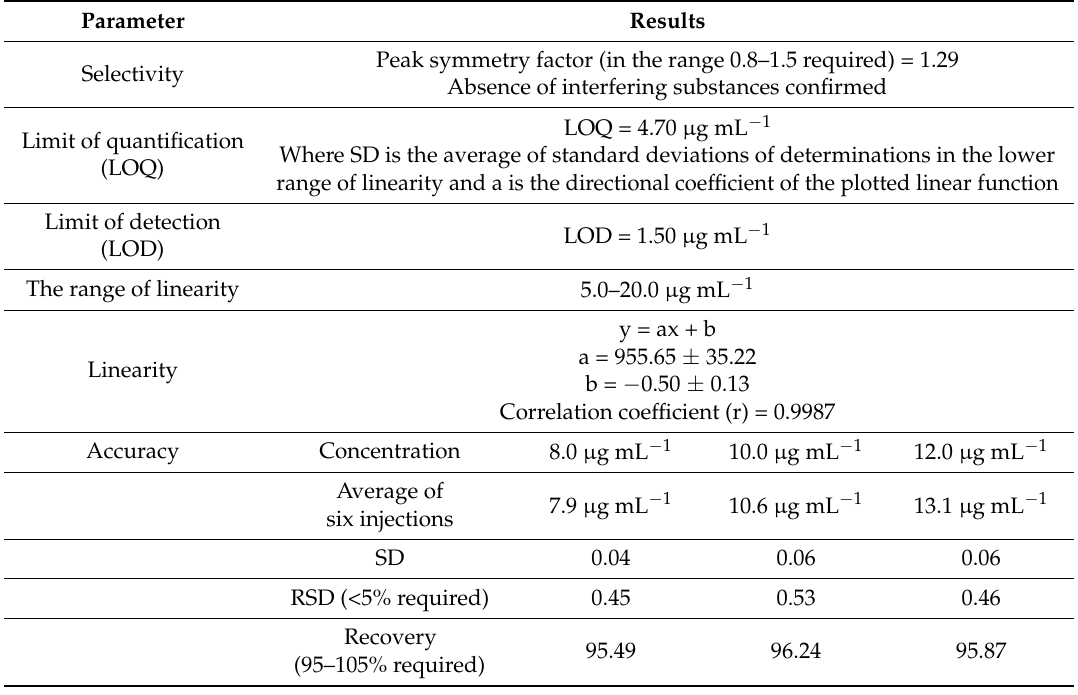
Table 3. Validation parameters of the HPLC-DAD method for the determination of benzocaine in a phosphate buffer of pH ≈